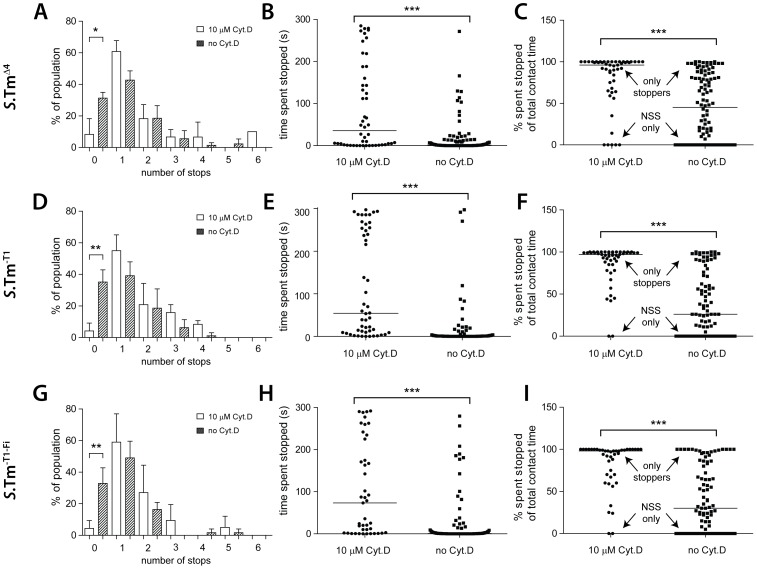
Host cell morphology affects the NSS pattern of S. Typhimurium.HeLa cells were either treated with 10 µM cytochalasin D or mock-treated and infected with S.TmΔ4(pGFP), S.Tm-T1(pGFP) or S.Tm-T1-Fi(pGFP), as indicated at an m.o.i. of 1.5. The infection process was imaged for 5 min by time-lapse fluorescence microscopy. Data for bacteria without cytochalasin D were taken from Fig. 1D–F and Fig. 2A–D and are displayed for comparison. (A), (D), (G) Fraction of bacteria making no stops or the indicated number of stops on the cell layer (compare Fig. 1E). The effect of cytochalasin D on the number of bacteria with no stops vs. one or more stops was statistically significant for all 3 strains (Fisher's exact test). (B), (E), (H) Cumulative time a single bacterium spent stopped over the entire duration of the contact with the cell layer. (C), (F), (I) Fraction of the contact time that a given bacterium spent stopped; the remaining percentage of time was spent in NSS. *: p<0.05; **: p<0.01; ***: p<0.0001.